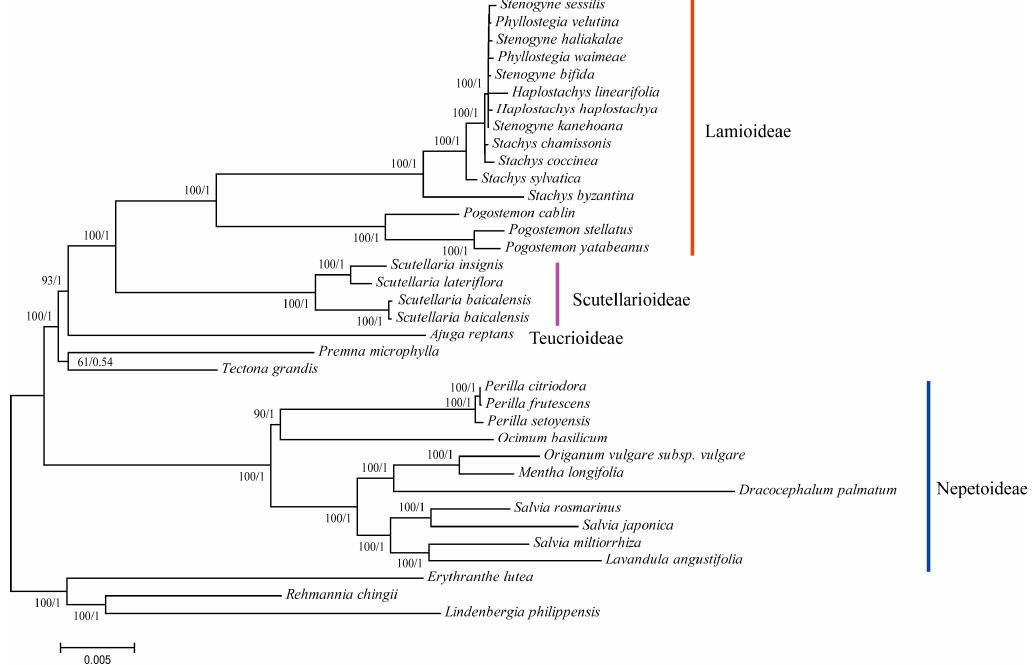
Figure 5. Phylogenetic tree reconstruction of 36 taxa using maximum likelihood and Bayesian inference based on the concatenated sequences of 84 genes. Maximum likelihood (ML) topology, with the ML bootstrap support value/Bayesian posterior probability given at each node.